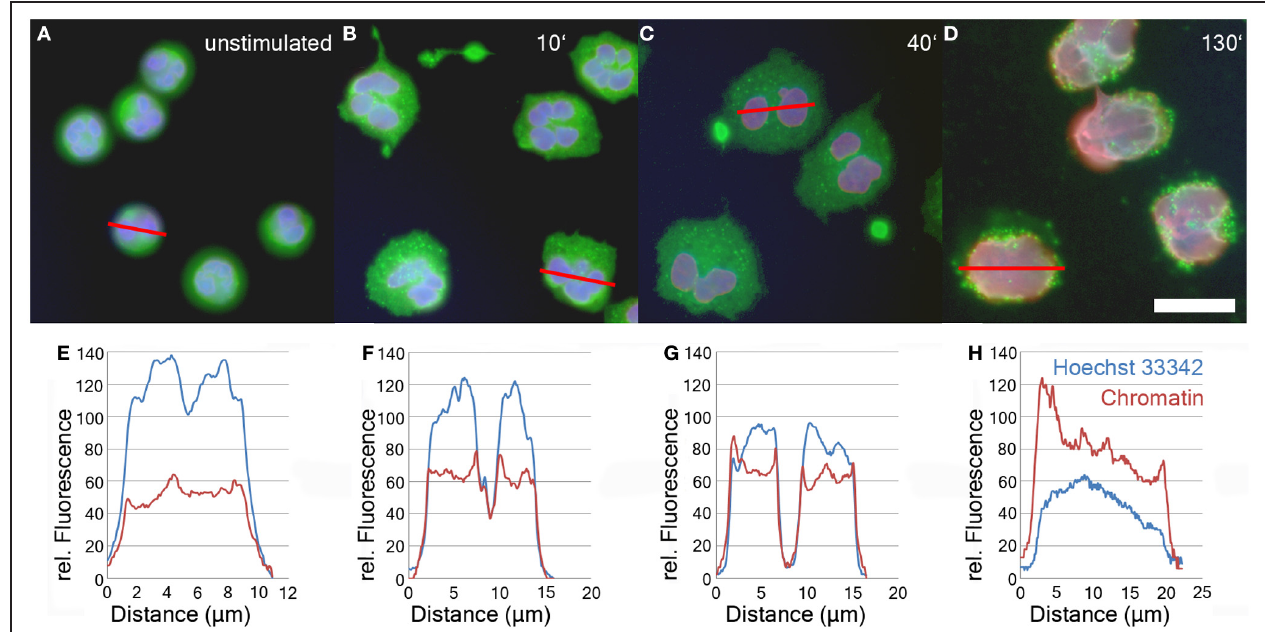
FIGURE 1 | Immunofluorescence analysis of unstimulated neutrophils (A) and neutrophils stimulated with 50nM PMA for 10‘(B), 40‘(C), and 130‘ (D). Blue: DNA (Hoechst 33342), red: chromatin (antibody PL2-3), green: